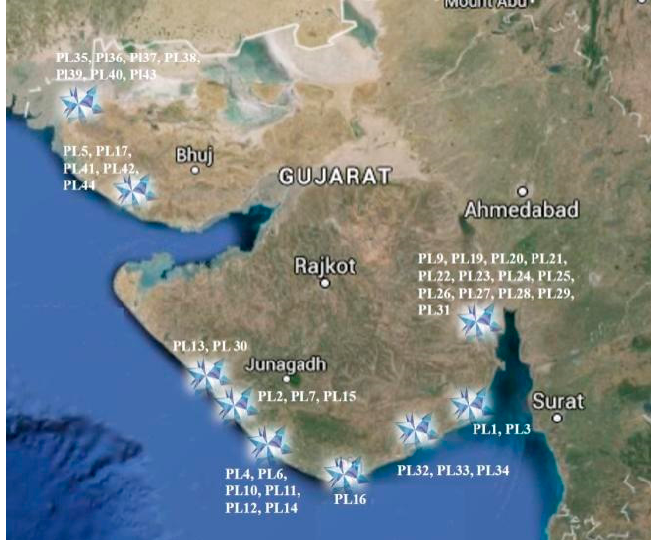
Figure 1. Distribution of ε -PL producing bacteria in seawater along the west coast of India.